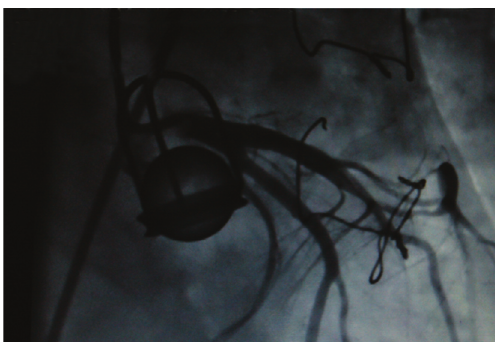
Figure 1: Angiography showing the functioning Star-Edwards Caged ball prosthesis at diastol.